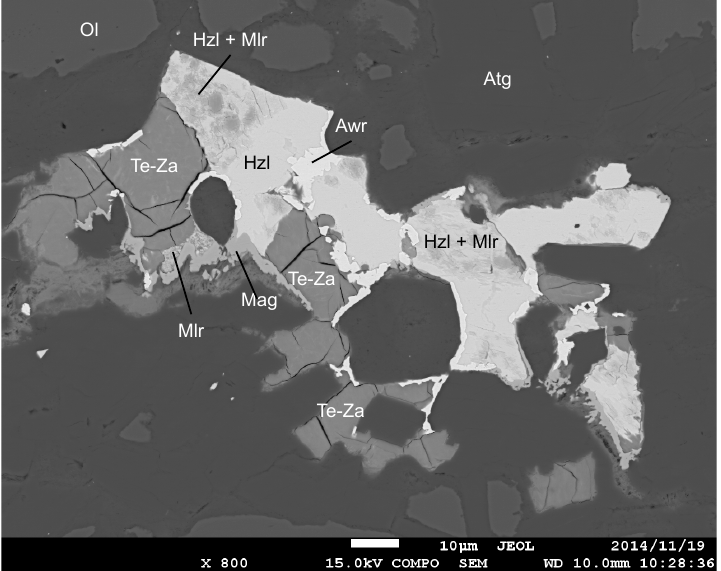
Figure 4. SEM (scanning electron microscope) image of a composite grain containing theophrastite-zaratite aggregate (Te-Za). Note the cracking in the Te-Za aggregate. Awr, awaruite. Hzl, heazlewoodite. Mlr, millerite. Mag, magnetite. Ol, olivine. Atg, antigorite. Bar is 10 µ m.